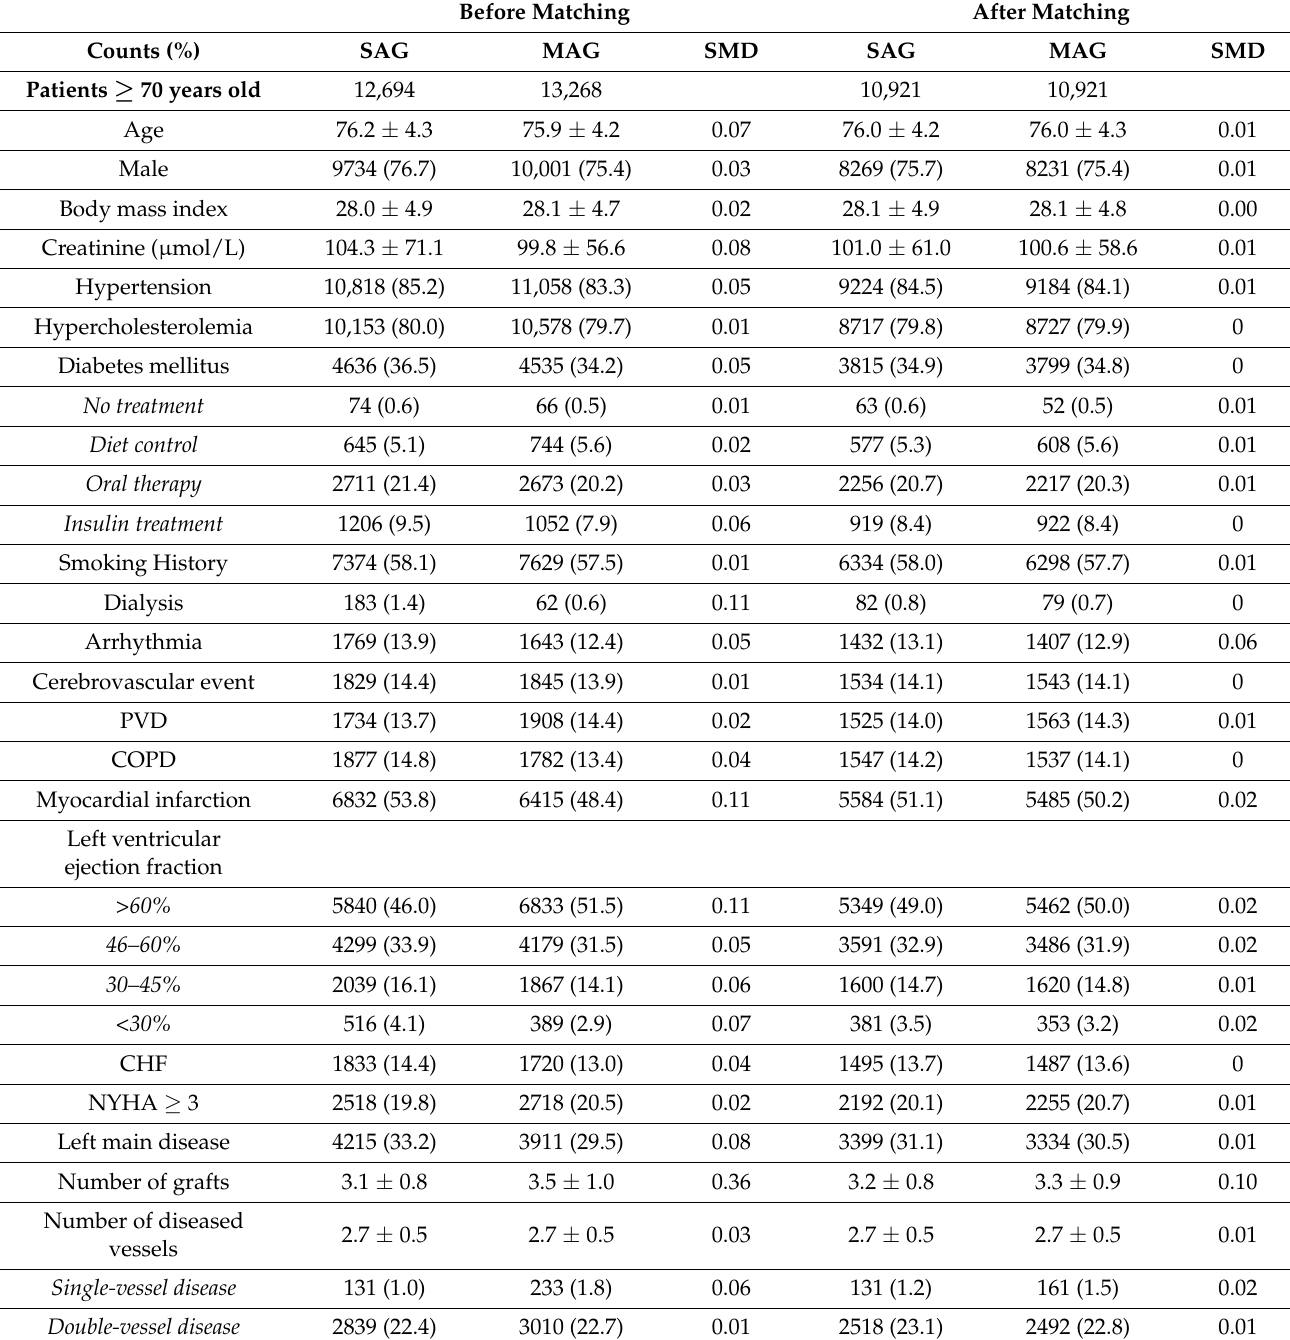
Table 1. Baseline characteristics of patients undergoing single arterial and multiple arterial coronary artery bypass grafting in Australia before and after propensity score